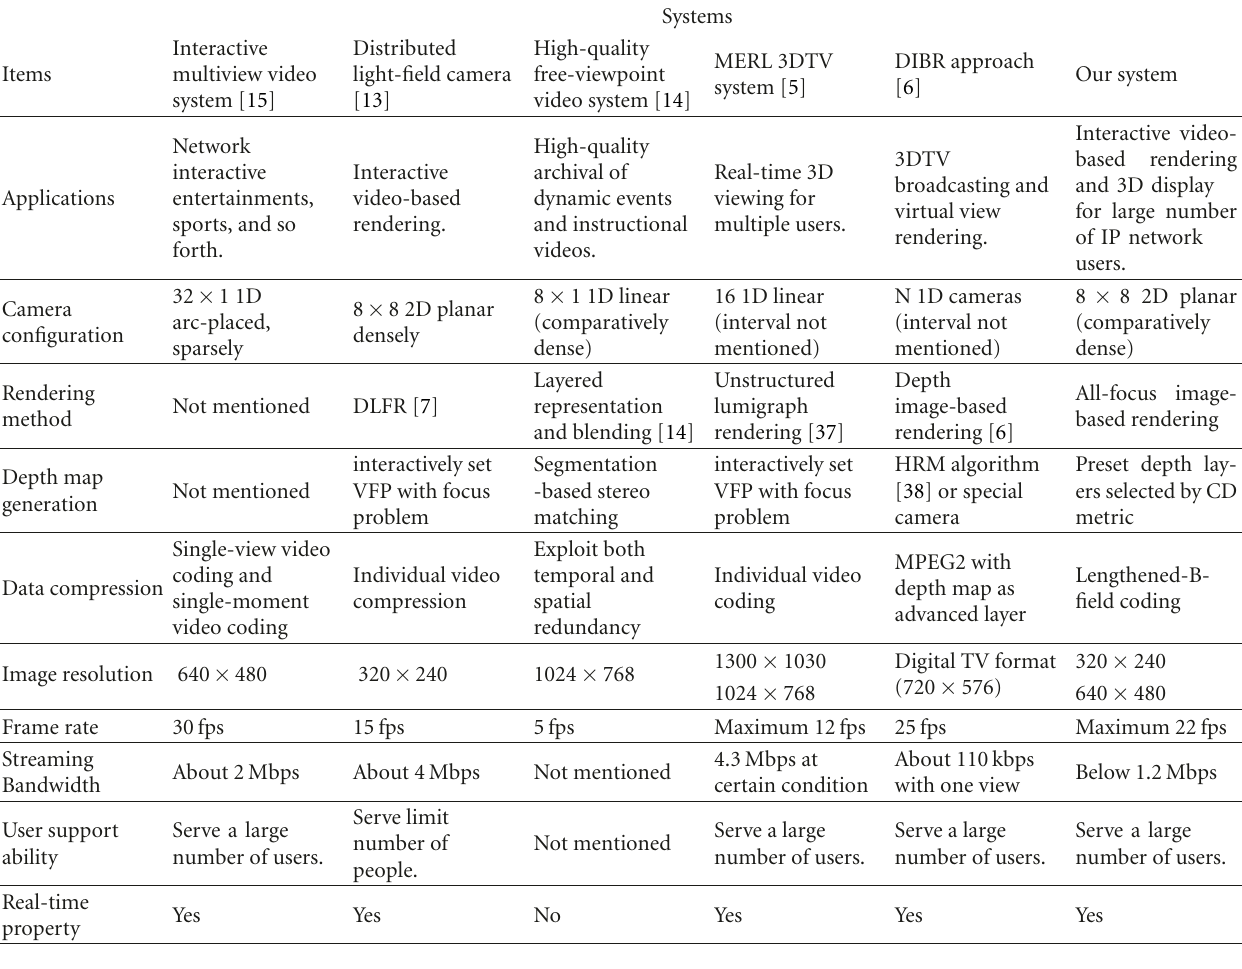
Table 2: Comparison of our system with the state-of-the-art 3DTV systems.